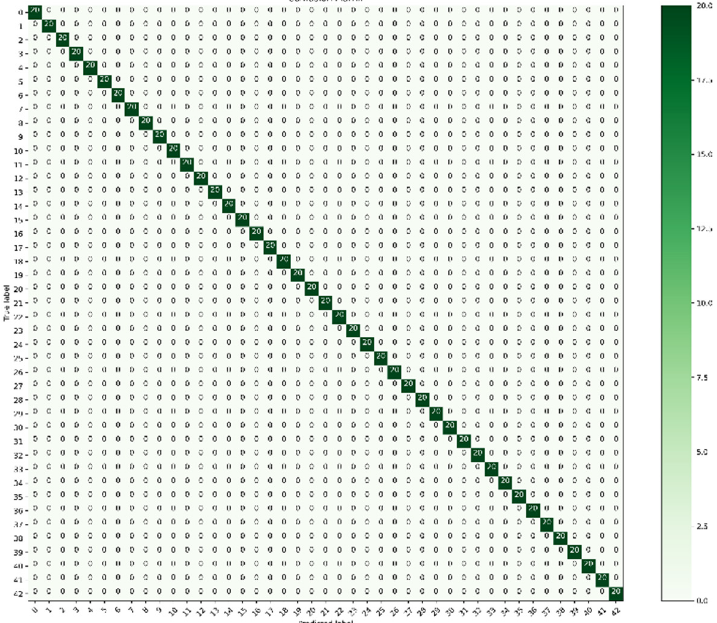
Figure 14. Confusion matrix in the process of associated fault diagnosis.